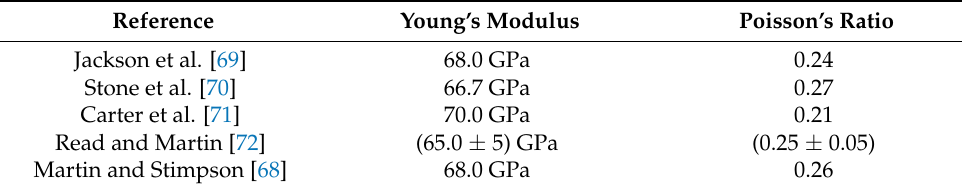
Figure 3. The instrumented 150 mm diameter cylinder of the Lac du Bonnet granite. Table 2. Elasticity properties of the Lac du Bonnet granite from the published